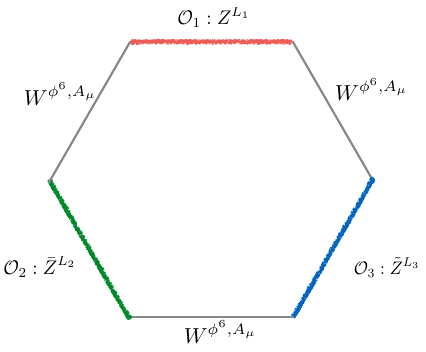
Figure 1 . Wilson loop with operator insertions. For a BPS con(cid:12)guration, we consider the following operators constructed by the complex scalars Z = (cid:30) 1 + i(cid:30) 2 and Y = (cid:30) 3 + i(cid:30) 4 : (cid:22) Y ) L 3 . Furthermore we choose (cid:30) and : ~ Z L 3 = ( Z + (cid:22) Z + Y O 3 (cid:0) loops, since there is no direct contraction between the inserted operators and the Wilson